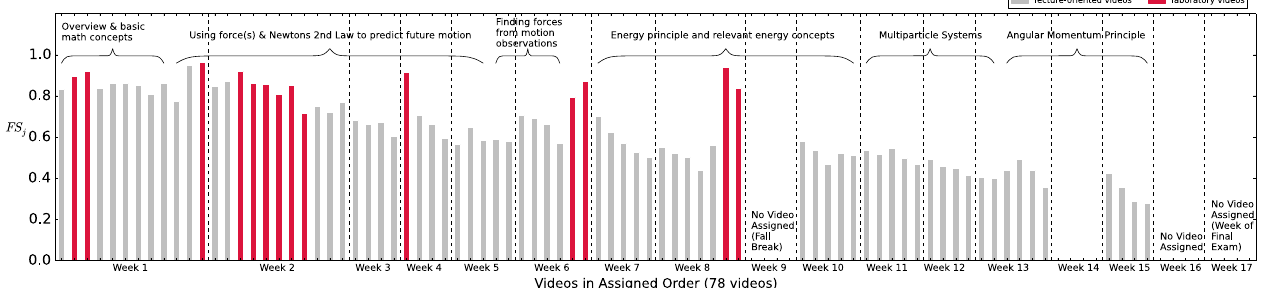
FIG. 4. Fraction of accessing students (FS j ) for each video. The lecture-oriented videos are represented in gray. The laboratory videos are represented in red. No videos were assigned in week 9, week 14, week 16, and week 17. Laboratory videos specific for the 1st, 2nd, 3rd, and 4th lab were assigned in weeks 1 and 2, week 4, week 6, and week 8, respectively. The 5th lab was a “ choose your own adventure ” lab, in which students were expected to take advantage of what they learned in the course to explore any kind of motion that was of interest to them. Therefore, no laboratory videos specific for this lab were provided. Weeks 1 and 2 also included supplemental lab videos concerning specific tools used in all lab activities instead of specific lab activities. Major topic breakdown for the lecture- oriented videos is indicated on the figure. The figure shows that students reduced their accessing of lecture oriented videos as time